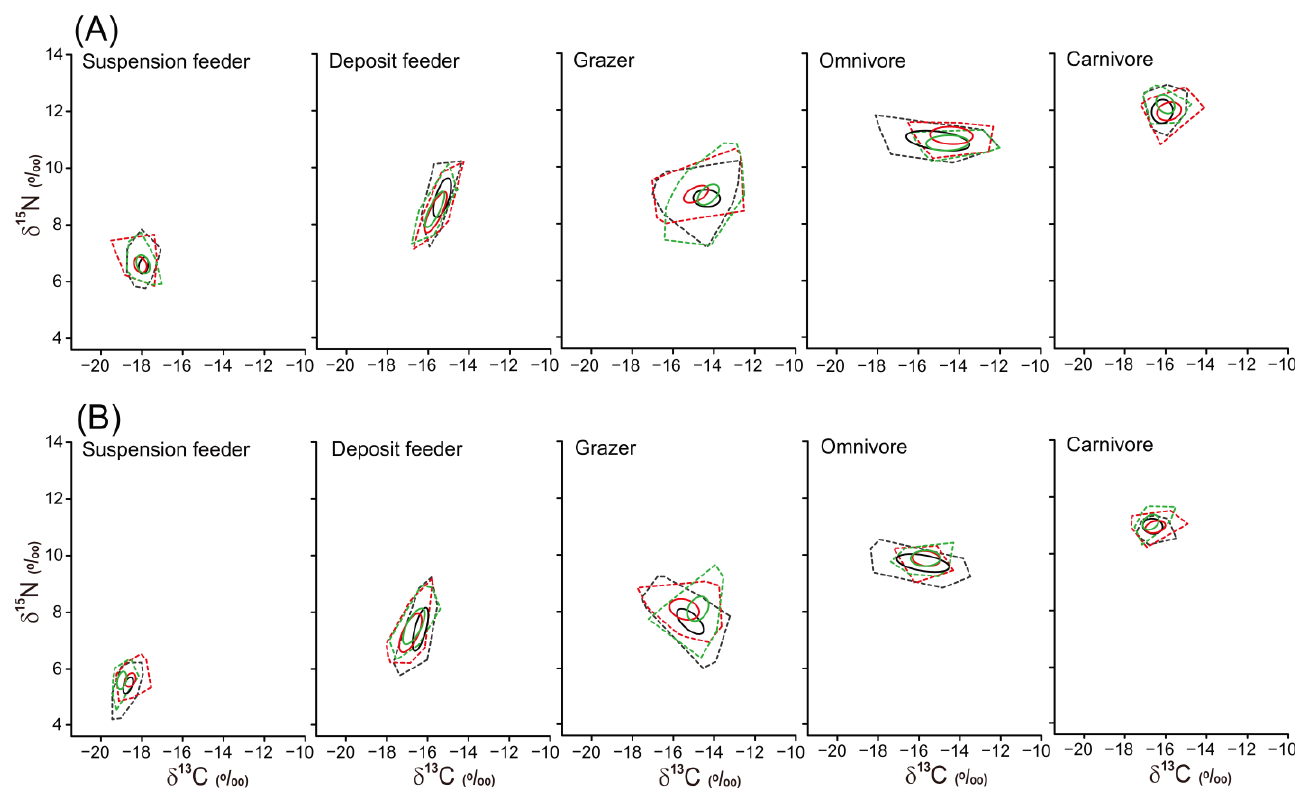
Figure 3. Isotopic niche comparisons of each feeding group (suspension feeder, deposit feeder, grazer, omnivore, and carnivore) estimated as the total area (TA, dotted lines) and standard ellipse area (SEAc, solid lines) among the two oil-impacted sites (Gurepo, red lines and Padori, green lines) and one non-impacted reference site (Yeonpo, black lines) in July ( A ) and November ( B ) using the Stable Isotope Bayesian Ellipse in R (SIBER) procedure.